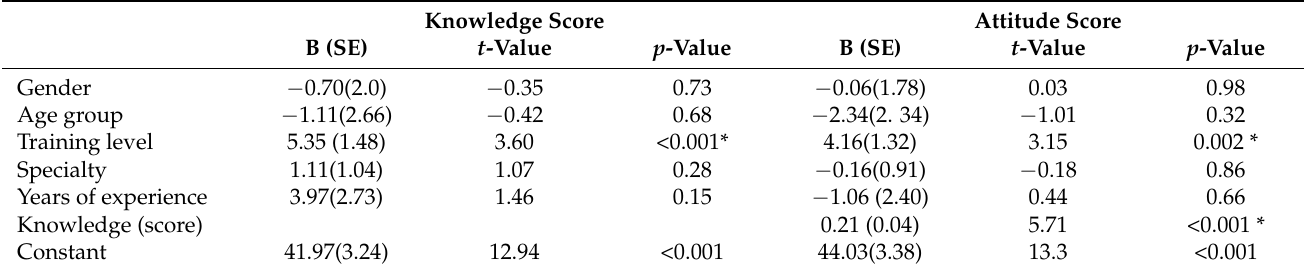
Table 6. Multiple regression analysis of knowledge and attitude scores on OSA by some characteristics among physicians.